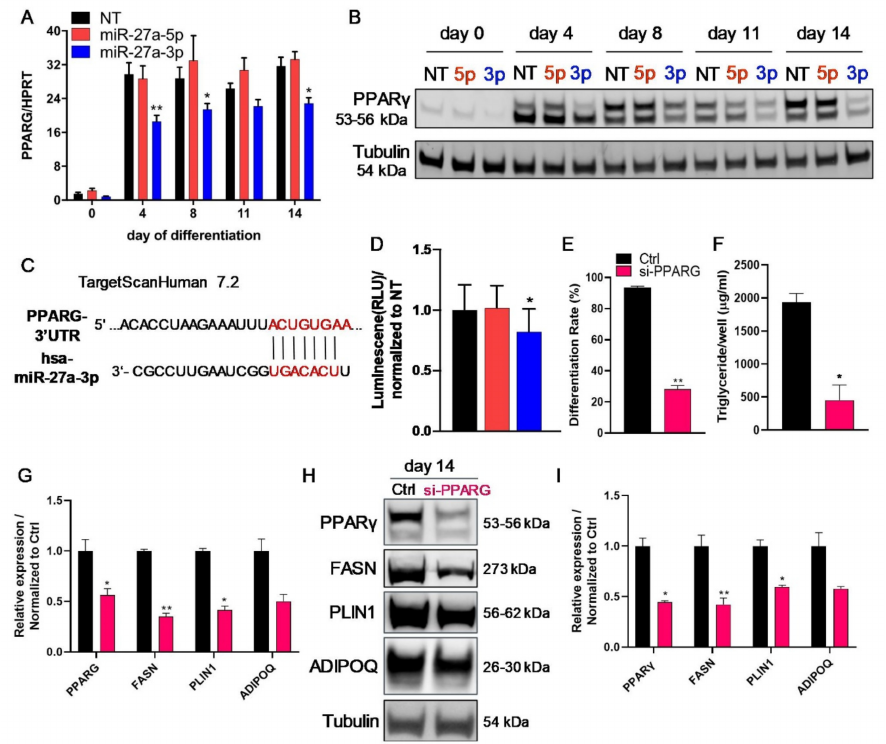
Figure 7. PPAR γ is a direct target of miR-27a-3p regulating adipogenesis. To assess if miR-27a-3p regulated its predicted target PPAR γ , SGBS preadipocytes were transfected 48 h prior to adipogenic induction with miRNA mimics or non-target control (NT, 20 nM), and additionally, a dual-luciferase reporter assay was performed in HEK293 cells. ( A ) mRNA level of PPARG as quantified by qPCR normalized to HPRT at indicated timepoints of adipogenic differentiation. ( B ) One representative Western blot from three independently performed experiments for PPAR γ using tubulin as loading control. ( C ) Illustration of the predicted binding site for miR-27a-3p in the 3 (cid:48) UTR in the human PPARG mRNA. ( D ) Results of the dual-luciferase reporter assay performed in HEK293 cells. Luminescence from firefly/Renilla luciferase activity was determined as indicated. ( E – I ) SGBS preadipocytes were transfected 48 h prior to adipogenic induction with either control non-target (Ctrl) or an siRNA pool targeting human PPARG (si-PPARG, 20 nM). Triglycerides, and RNA and protein samples were collected on day 14 of the differentiation process. ( E ) Differentiation rate and ( F ) triglyceride content were measured on day 14. ( G ) mRNA expression of PPARG and adipogenic markers was quantified by qPCR, normalized to HPRT, after PPARG knockdown. ( H ) One representative Western blot out of three independent experiments after PPARG knockdown in SGBS cells. ( I ) Densitometric analysis of all Western blots was performed on day 14 of adipogenesis, normalized to tubulin. Statistics: results are displayed as means and SEMs of 5 ( A ) and 3 ( D – G , I ) independent experiments. Two-way ANOVA ( A ) and one-way ANOVA ( D ) with Dunnett’s correction with respect to NT for the same time point; t -test ( E – G , I ) with respect to Ctrl ; * p < 0.05; ** p < 0.01. HPRT: hypoxanthine-guanine phosphoribosyltransferase; PPARG/PPAR γ : peroxisome proliferator-activated receptor γ ; FASN: fatty-acid synthase; PLIN1: perilipin; ADIPOQ: adiponectin; 5p: miR-27a-5p; 3p: